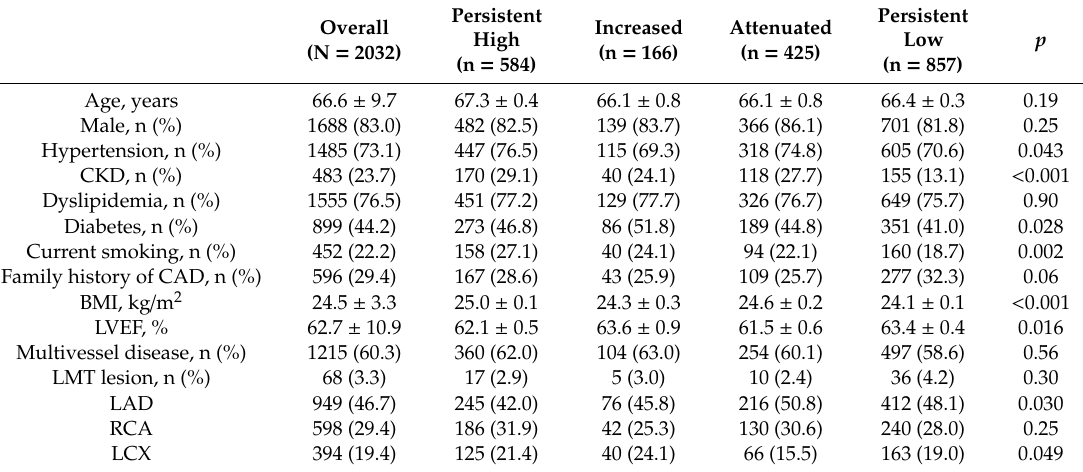
Table 1. Baseline Characteristics of the Study